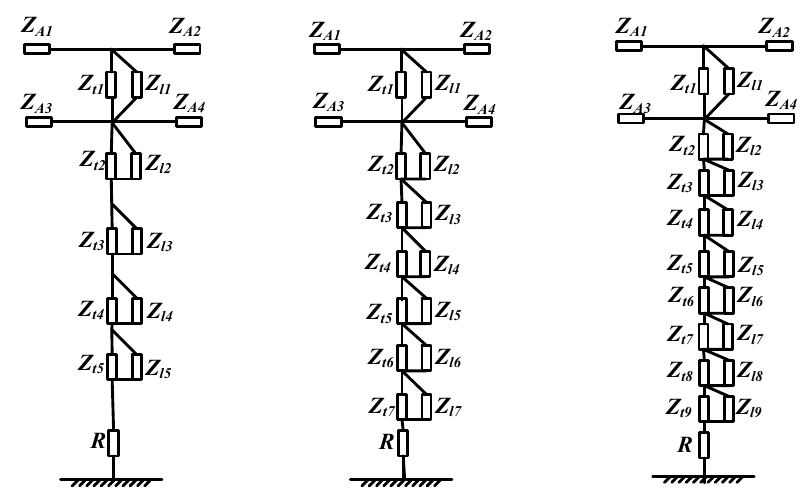
Figure 8. Tower model when the nominal height is divided into 4, 6, and 8 segments. Table 3. Parameters for four segments of the nominal height.